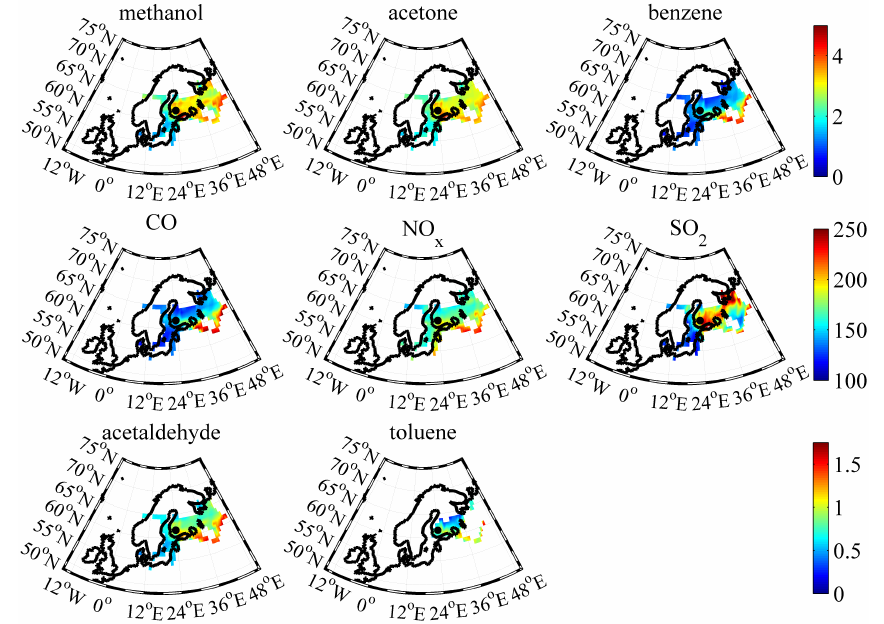
Figure 3. Mean trajectory fields for selected VOCs and trace gases (ppb v ) during the forest fires in summer 2006. VMR scales are presented on the right, with the scale for each compound being multiplied in the case of each compound by the indicated factor 10, 100 or 1000 if needed. Topmost row: methanol, acetone, and benzene (benzene multiplied by 10). Middle row: CO, NO x (NO x multiplied by 10), and SO 2 (SO 2 multiplied by 100). Bottom row: acetaldehyde and toluene (toluene multiplied by 10). The SMEAR II site is marked by a dot in the map.